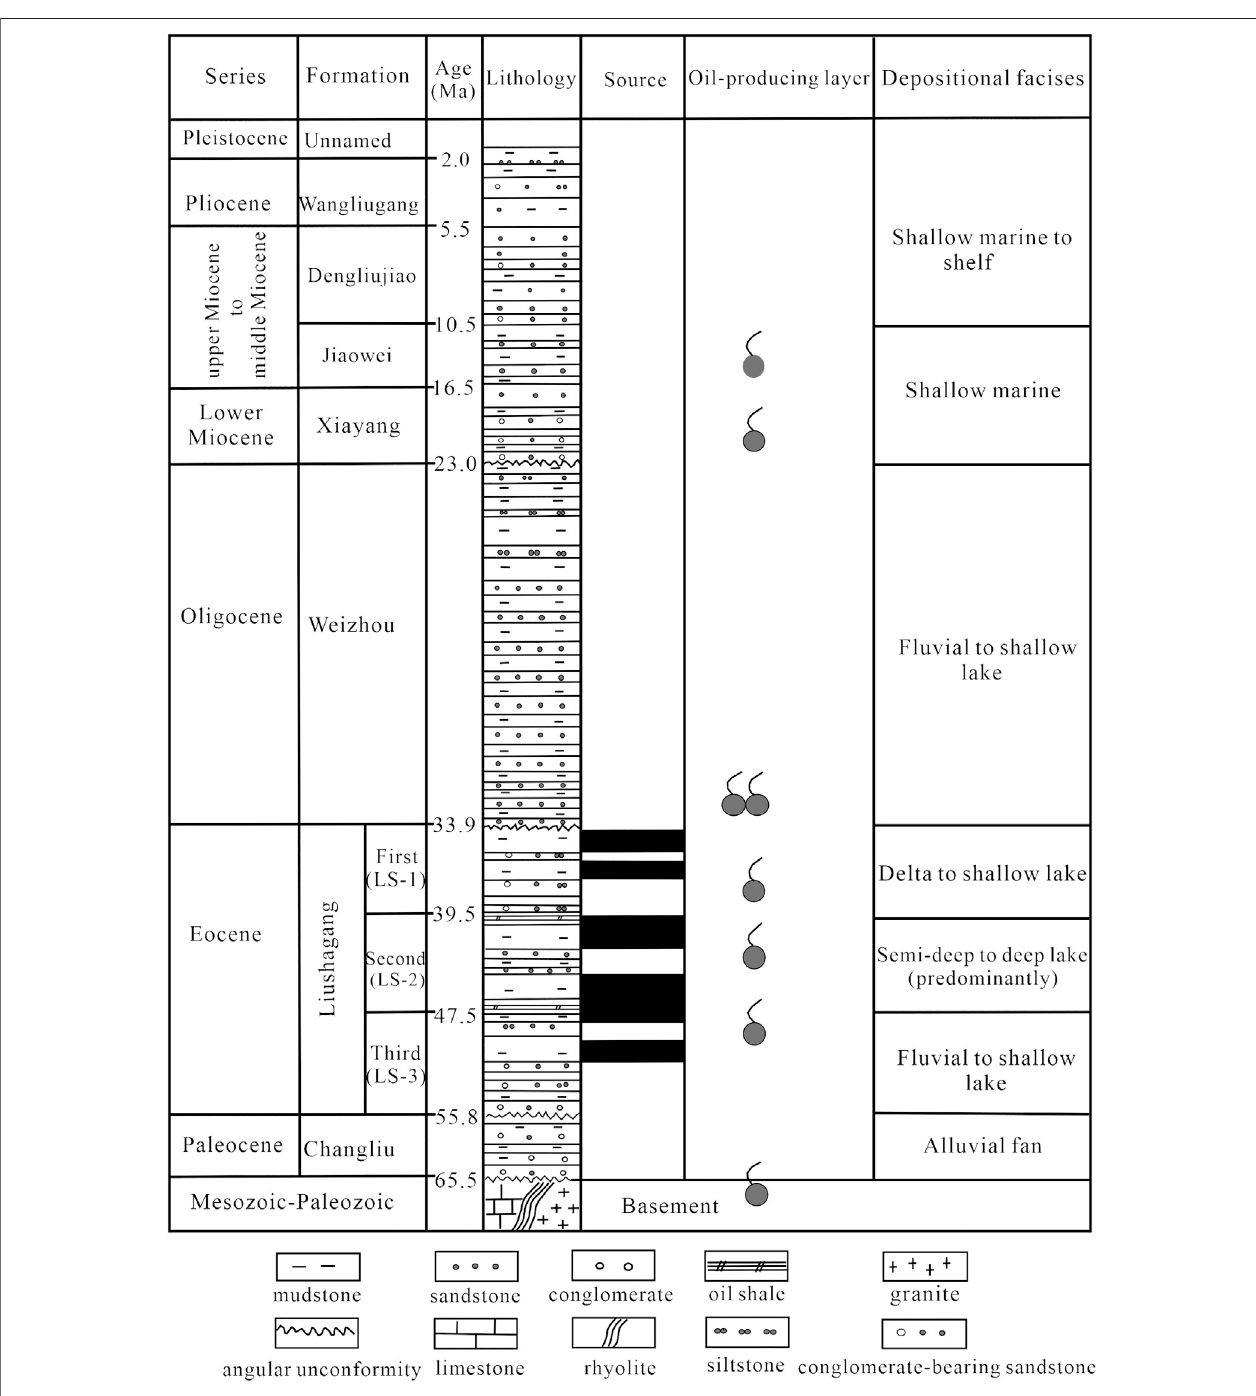
FIGURE 2 | General stratigraphic column of the Wushi Sag in the Beibu Gulf Basin (modi fi ed after (Huang et al., 2017)).